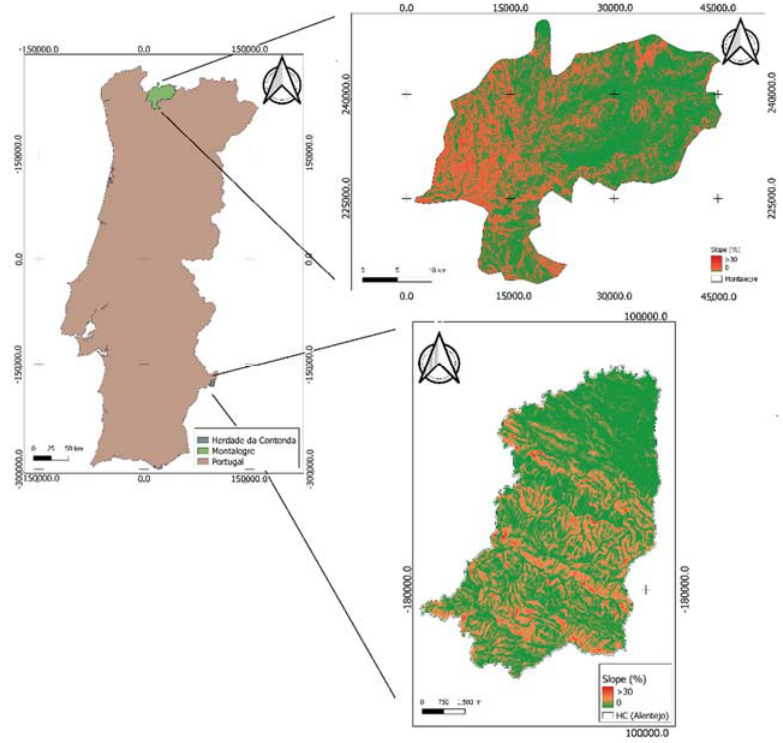
Figure 2. Montalegre and Alentejo location in Portugal mainland (adapted from [30,41]).